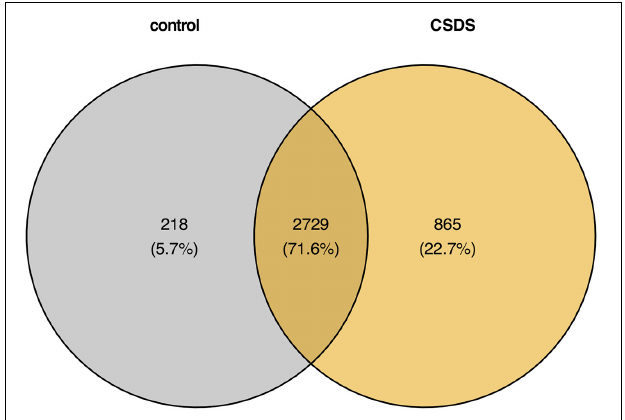
FIGURE 2 | Comparison of genomic locations of G-to-A RNA editing events in controls and